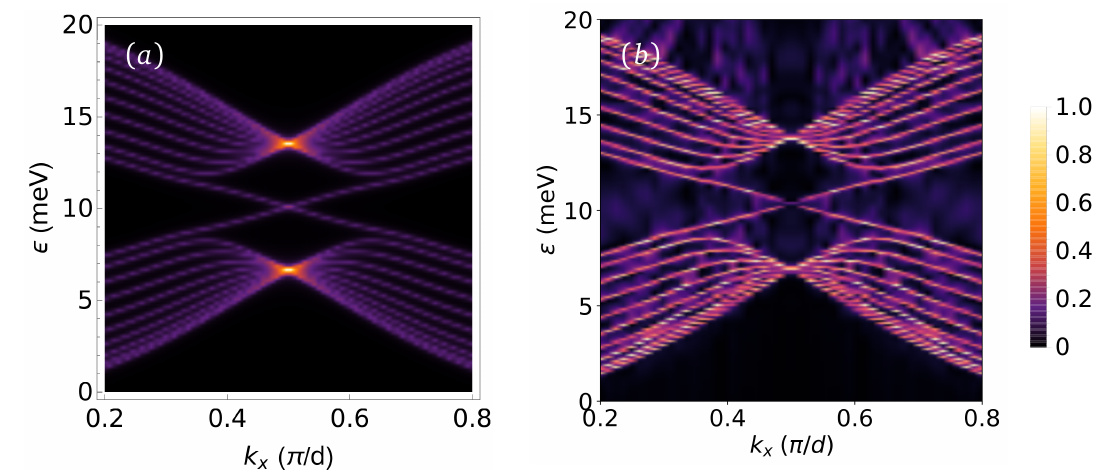
Figure 3: Spectral functions for a ribbon geometry. ( a ) Floquet spectral func- ( ε ) for a ribbon with n = 20 and spin parameters S = 3 / 2, J = 2.26 meV, tion A F y k J (cid:48) = 0.05 meV and χ = 0.13 meV. ( b ) Non-equilibrium spectral function A τ = 8.2 ps for a zig-zag ribbon with n = 20 and electronic parameters t = 50 meV, y = 12 meV. The optical field has a frequency (cid:126) ω = 1 eV and field U = 1.25 eV and J D strength E = 10 9 V / m. The values of the spectral functions are normalized to the highest value, and the values range from zero (black) to one